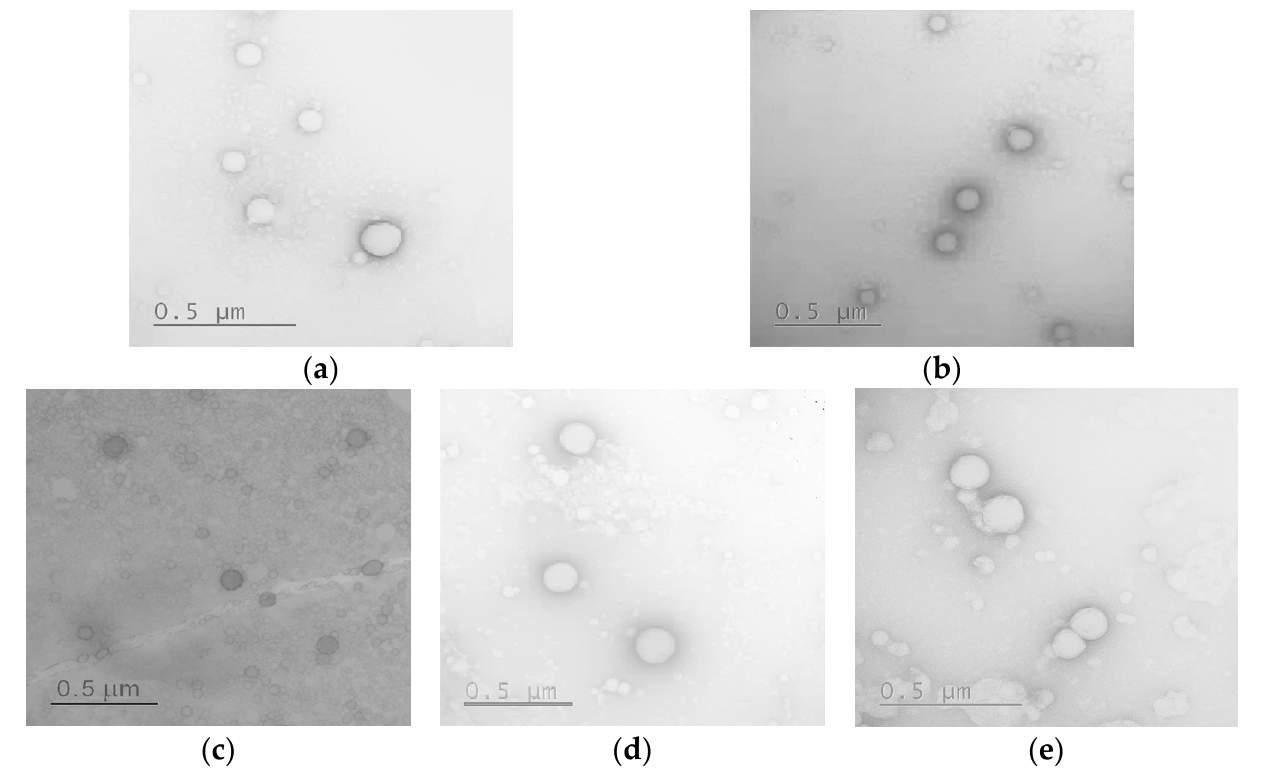
Figure 9 . TEM images of nanoparticles and nanoparticle-based polypeptide conjugates with DEX (scale bar 0.5 µ m): P[EF]-2 ( a ), P[EF]-2-DEX ( b ), P[KF] DL -2 ( c ), P[KF] DL -2-DEX ( d ), P[KF] DL -2- DEX/HEP ( e ).